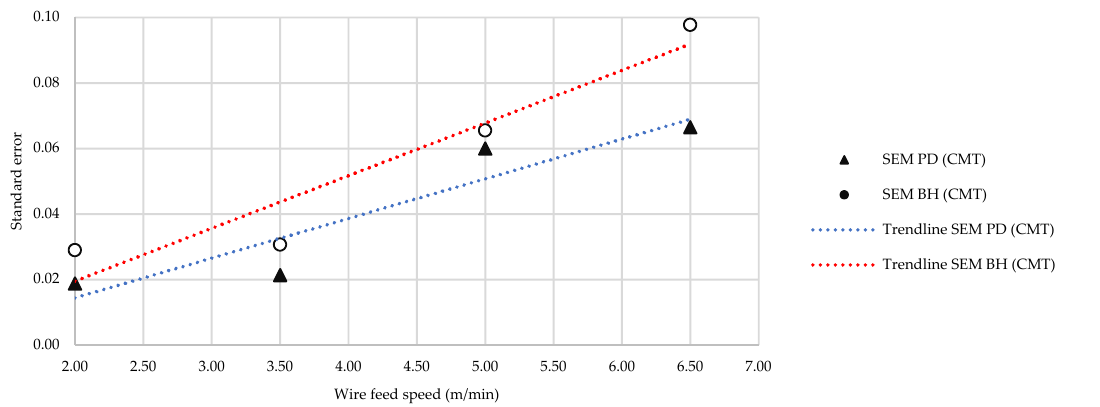
Figure 10. Standard error values plotted against wire feed speed for CMT specimen penetration depth and bead height.